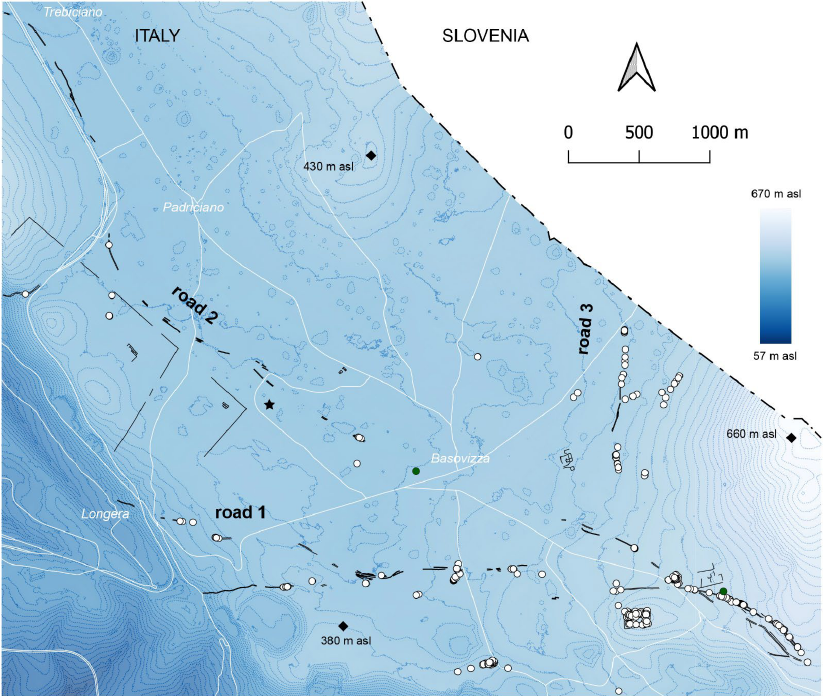
Figure 3. Main archaeological features in the investigated area (black lines) and associated Roman finds: shoe hobnails (white circles); coins (green circles); possible graveyard (black star). Modern roads and locations of modern villages are shown in white.